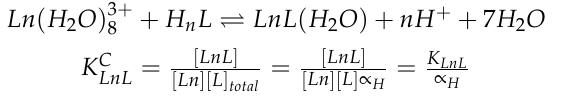
Figure 3. Structure of Gadopiclenol, a macrocyclic pyclen-based contrast agent.